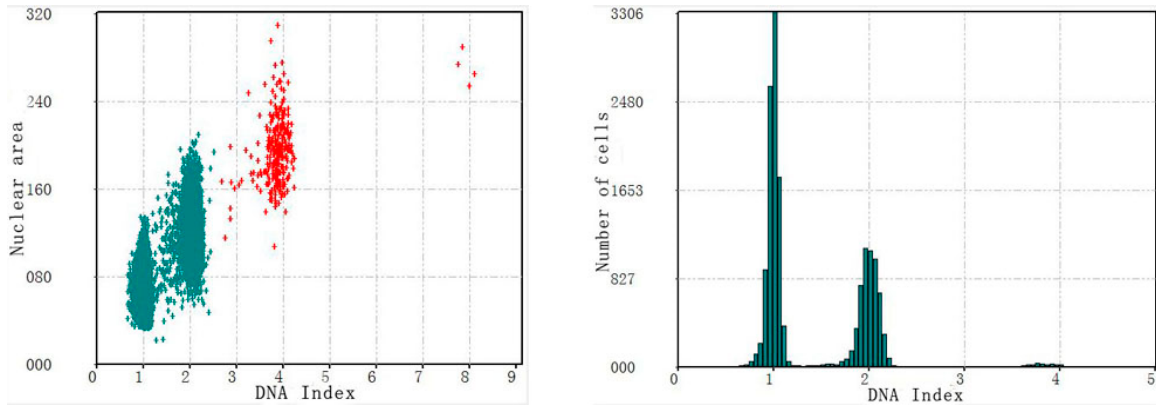
Figure 7. The evaluation result using the mouse liver smear.